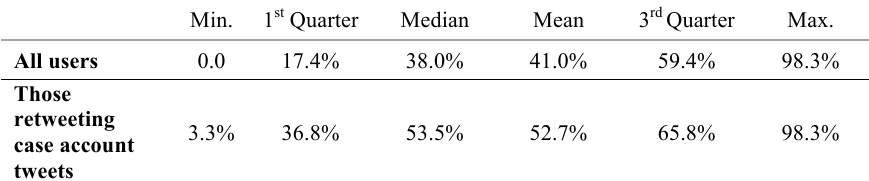
Table 9 . Statistics of the retweet percentage for all users and those who had retweeted case account tweets. Min. 1 st Quarter Median Mean 3 rd Quarter Max. All users 0.0 17.4% retweeting